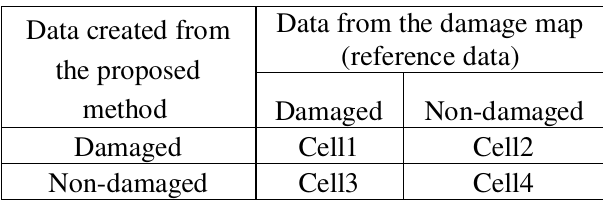
Figure 2 . Accuracy assessment of each